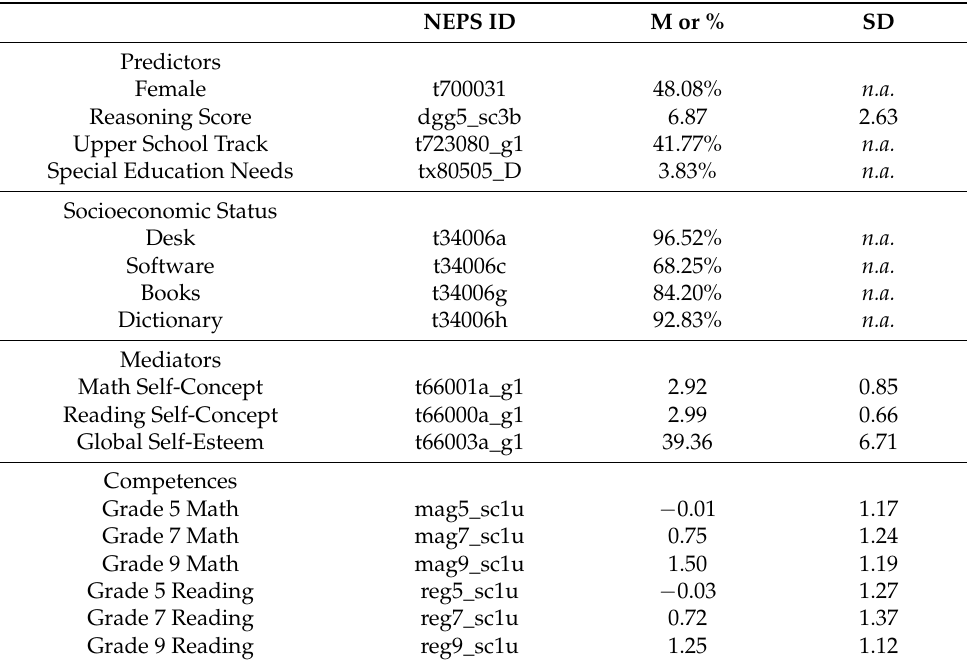
Table 1. Modelled variables and their characteristics in the imputed data.